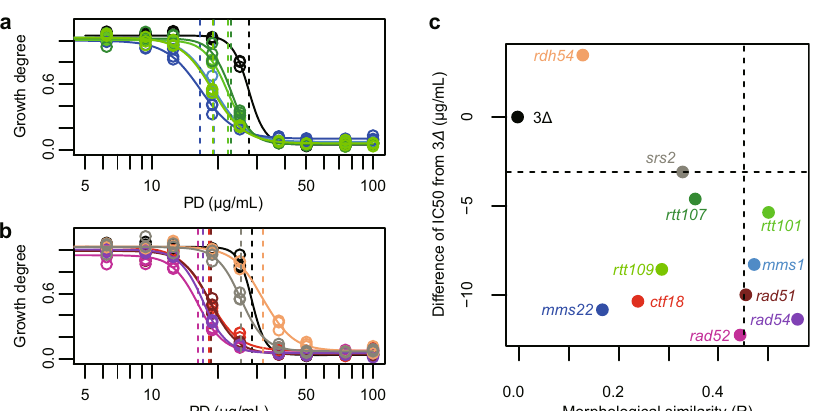
Fig. 7 Sensitivity of poacidiene in several gene-deletion mutants defective in the recombinational repair pathway. Inhibitory effects of poacidiene (PD) for cell growth in mutants of a Cul8-RING and b the recombinational repair pathway. Vertical lines indicate estimated IC 50 values. Colors correspond to strains indicated in ( c ). c Distributions of morphological similarity and IC 50 values. The dashed lines represent signi fi cantly different lines compared to 3 Δ ( p < 0.05, likelihood ratio test after Bonferroni